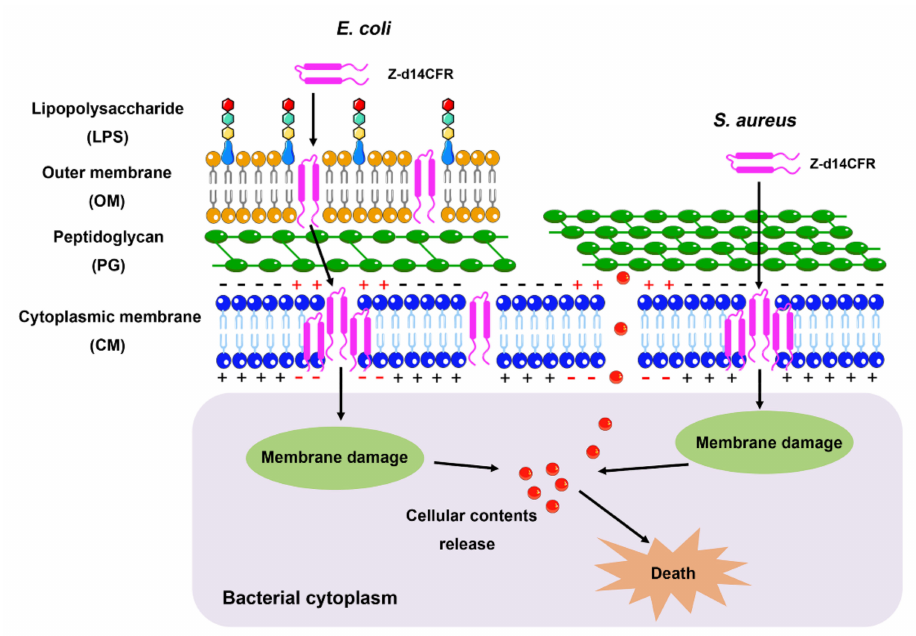
Figure 8. Possible mechanism of Z-d14CFR against E. coli and S. aureus . Z-d14CFR binds to bacterial membranes through electrostatic interactions, induces cytoplasmic membrane depolarization, inserts into the cell membranes and forms β -barrels, thereby disrupting the integrity of cell membranes, promoting the release of cellular contents and then killing the